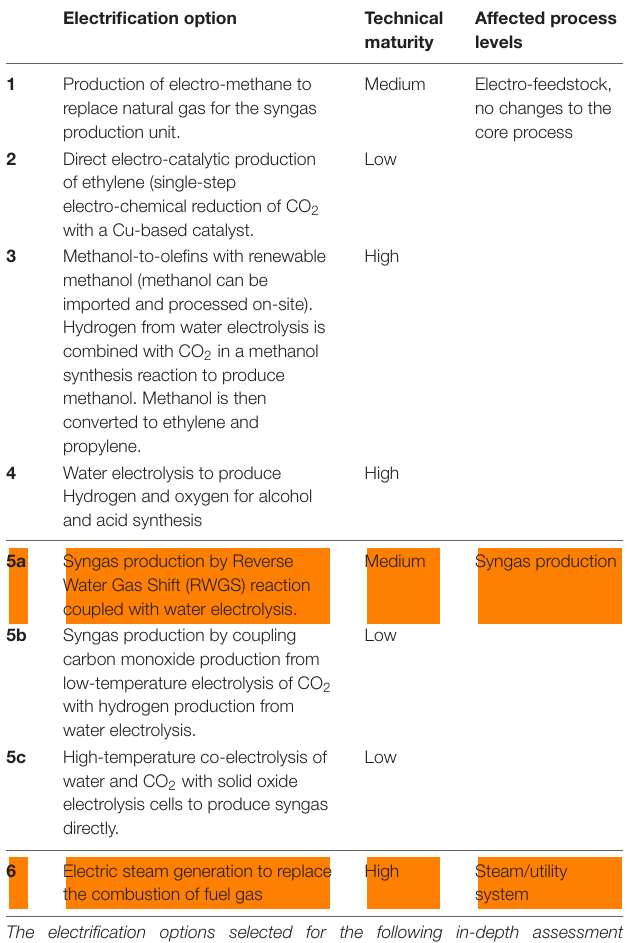
TABLE 2 | Detailed description of the process electrification options for the oxo synthesis plant including technical maturity and affected process levels (DECHEMA, 2017; Foit et al., 2017; Reller et al.,